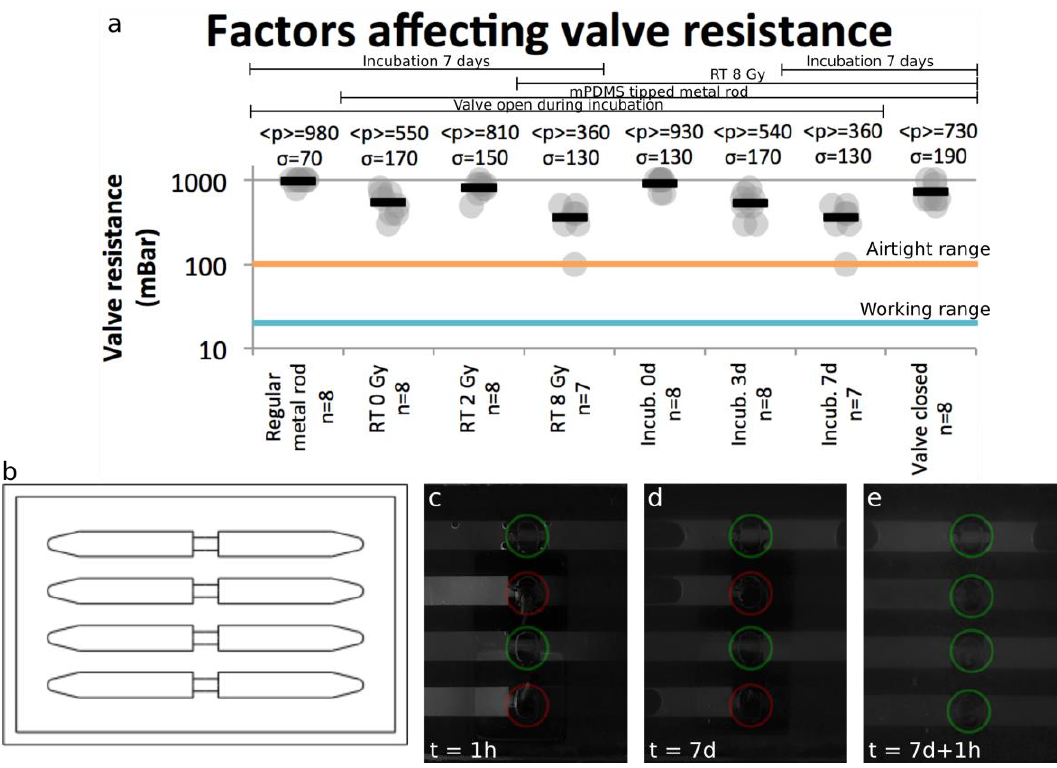
Figure 3. Characterization of valve resistance to flow and diffusive mass transfer (all data shown) ( a ) Effect of various parameters (type of metal rod used, radiotherapy (RT) dose, incubation time and state of valve in the incubator) over valve resistance in mBar (1 mBar = 1 cm of H 2 O); ( b ) Schematics of device channel layer mold used for individual test valves (ITV); ( c – e ) Small molecule (333 Da) diffusion across the closed valve. The valves in green represent open valves, while the ones in red are closed.